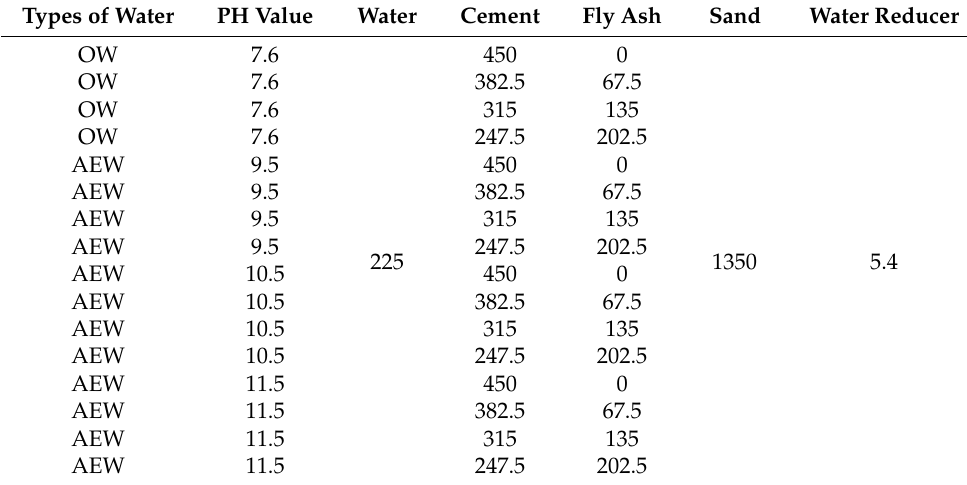
Table 5. Mix proportion of the fly ash mortar (kg/m 3